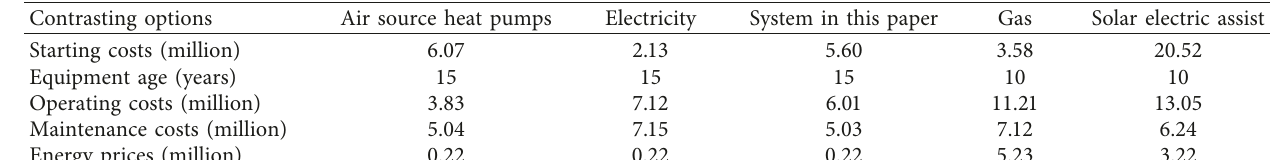
Table 4: Comparison of annual input costs of various programs.